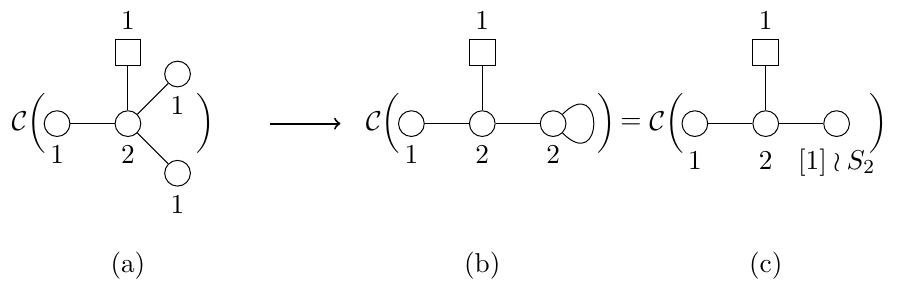
Figure 6 . The Coulomb branch of the D 4 quiver (left) is orbifolded by an S 2 action into a Coulomb branch shared by two distinct